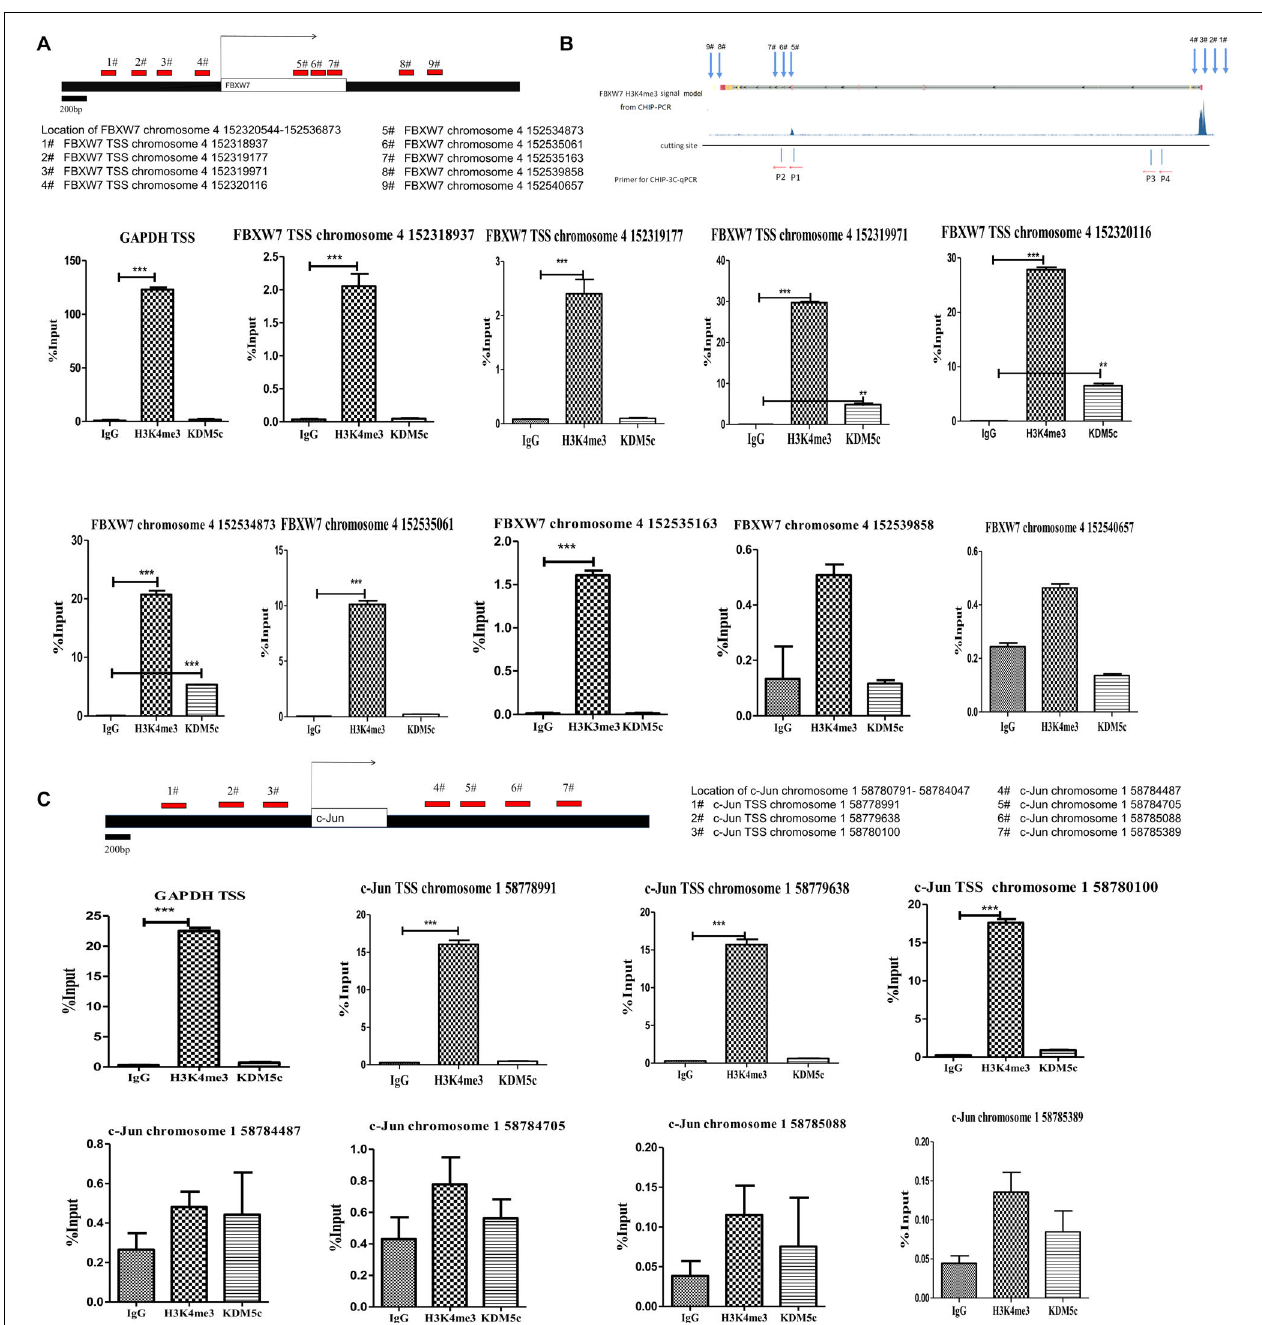
FIGURE 3 | H3K4me3 modification level and its binding proximity to KDM5c as determined by ChIP-qPCR assays. (A,B) Primer locations selected according to the H3K4me3 distribution patterns in the FBXW7 gene. The #1–4 primers, respectively, anneal to chromosome 4 152318937, 152319177, 152319971, and 152320116 in the TSS region of FBXW7; the #5–9 primers, respectively, anneal to chromosome 4 152534873, 152535061, 152535163, 152539858, and 152540657 in the downstream of the FBXW7 gene. The H3K4me3 peak distribution was determined by ChIP-qPCR using H3K4me3-specific antibodies. The location of KDM5c reciprocal DNA was determined by KDM5c-specific antibodies. The structure diagram shows the relationship between the loci and the anchor points in 3C-CHIP (showed in Figure 4 ) (B) . The ChIP-qPCR values are shown below. H3K4me3 enrichments were tested in #3–4 and #5–6 locations in FBXW7 gene. Enrichment of KDM5c was detected in the #3–4 and #5 locations in the FBXW7 gene. (C) Primer locations chosen according to the H3K4me3 distribution patterns in the c-Jun gene. The #1–3 primers, respectively, anneal to chromosome 1 58778991, 58779638, 58780100 in the TSS region of the c-Jun gene; the #4–7 primers, respectively, anneal to chromosome 1 58784487, 58784705, 58785088, and 58785389 in the downstream of the c-Jun genes. A H3K4me3 enrichment was tested in the #1–3 locations. And no obvious enrichment of KDM5c also was detected in the c-Jun gene. Experiments were repeated three times, each with three qPCR measurements, and the value for the representative experiment is shown as the mean ± SEM. * Above the bars indicates significant difference; P > 0.05; * P ≤ 0.05; ** P ≤ 0.01; *** P ≤ 0.001.